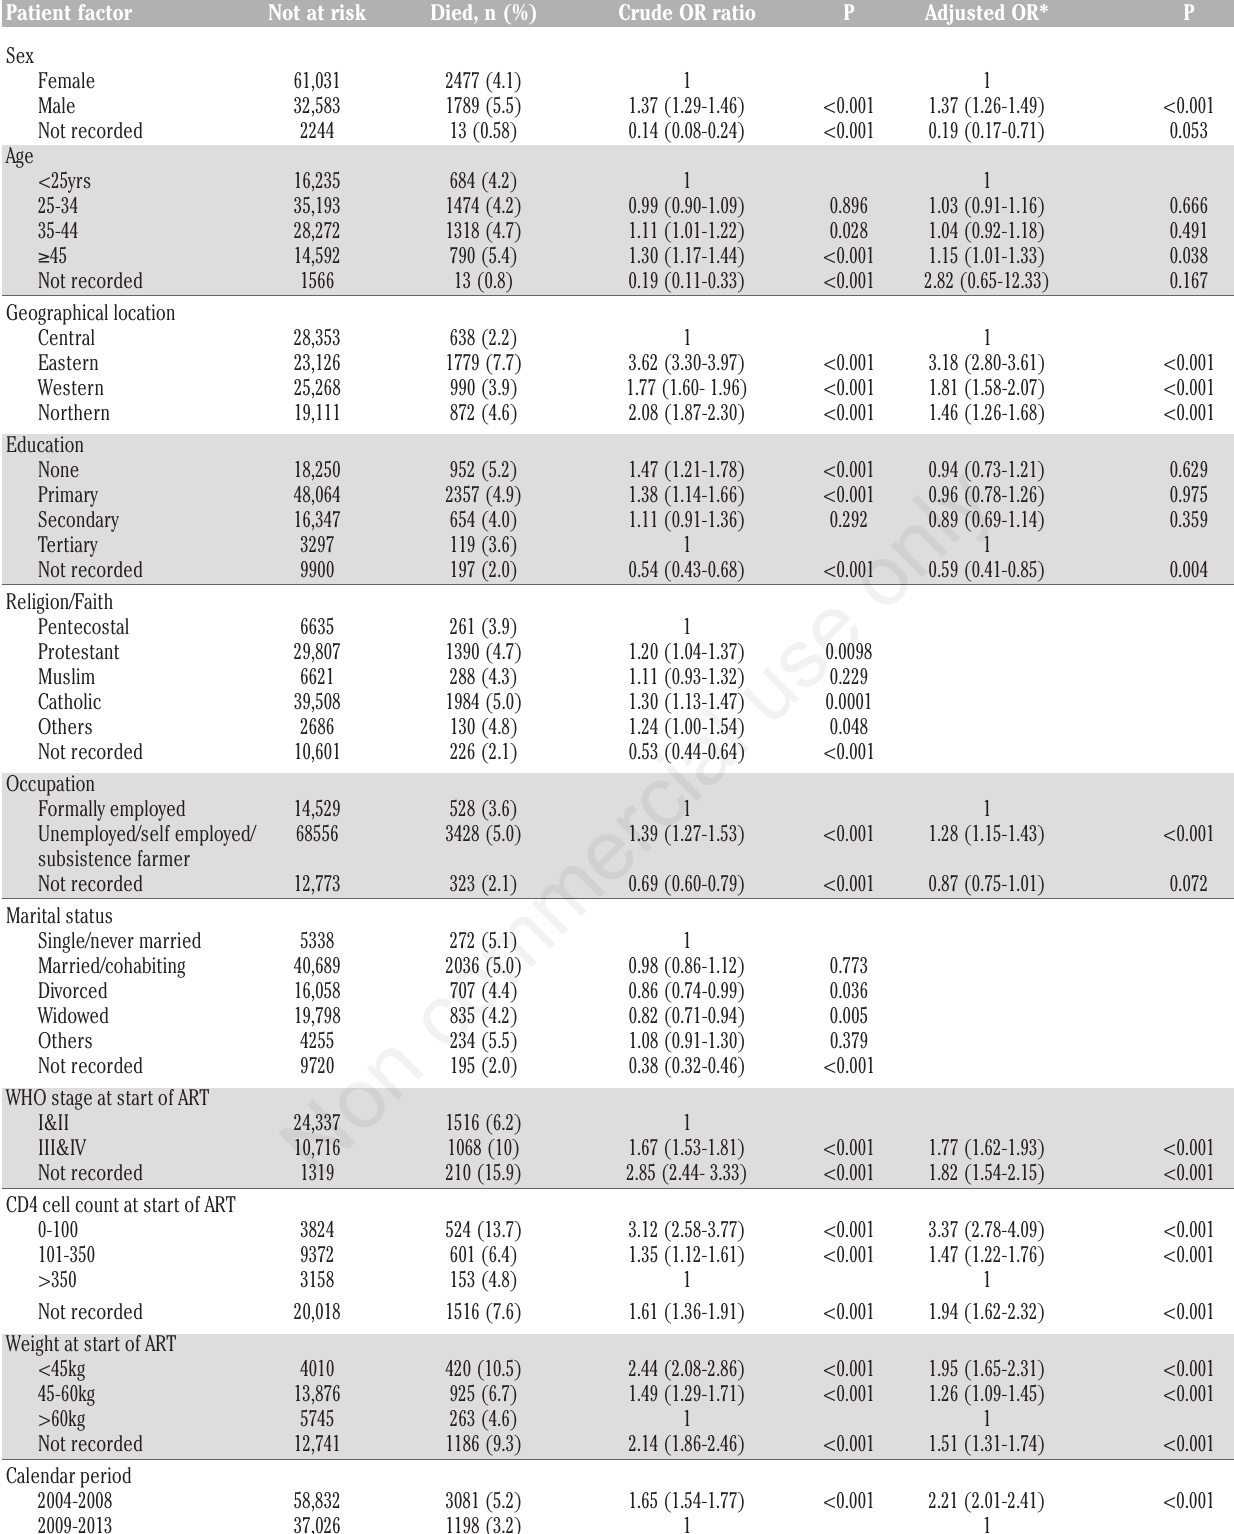
Table 4. Factors associated with mortality among HIV+ individuals from 4 different geographical areas in Uganda, Odds Ratio (OR, 95%CI). Patient factor Not at risk